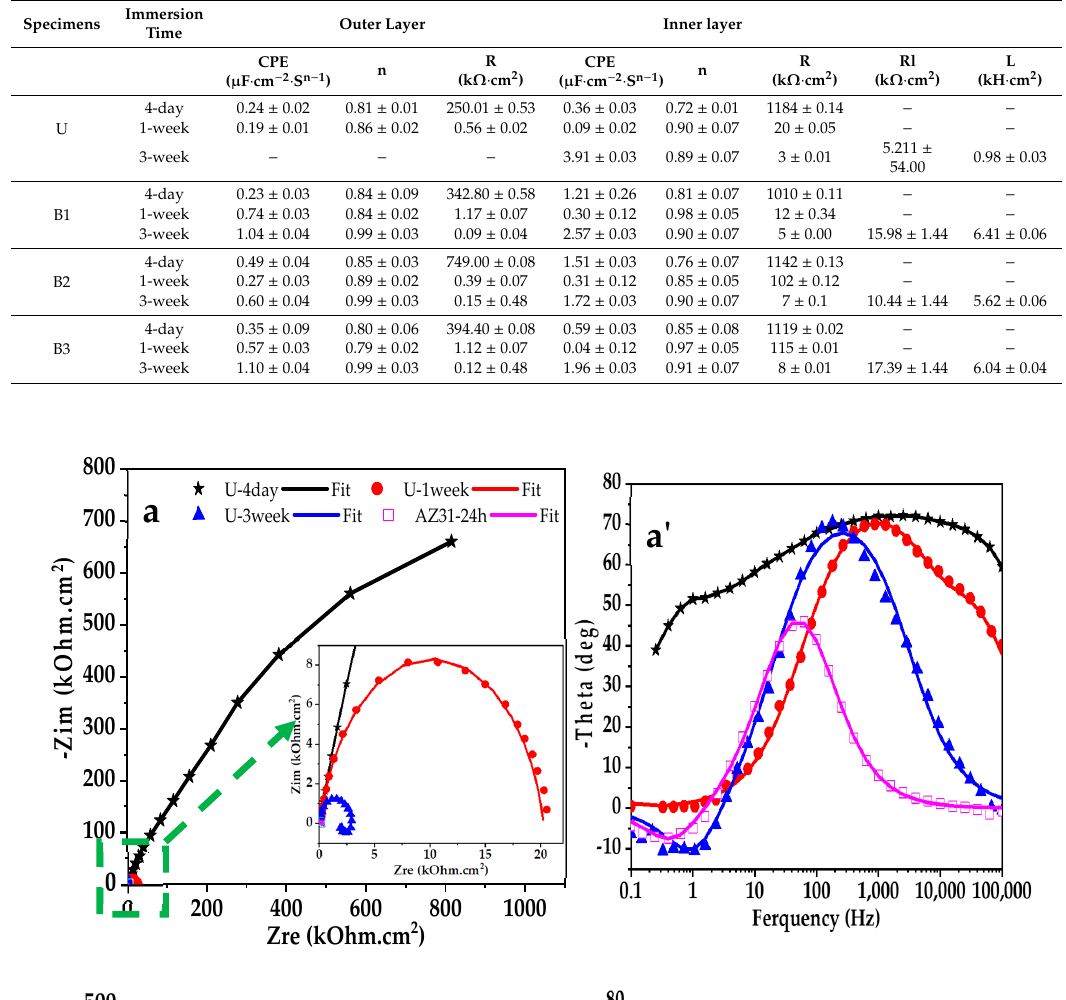
Table 4. Electrical elements values extracted for EIS diagrams using Zview software for U, B1, B2 and B3.